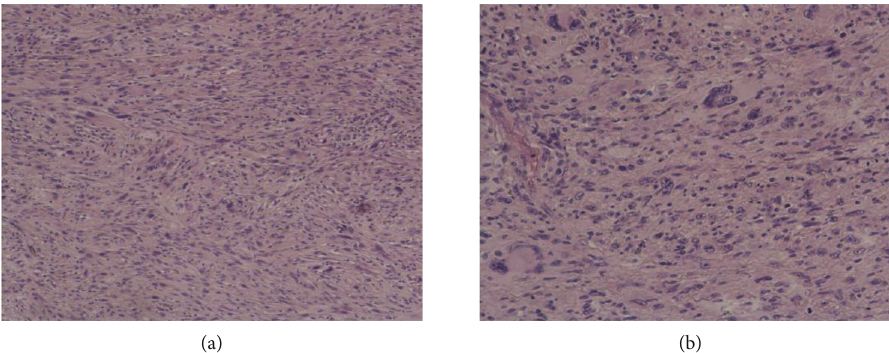
Figure 1: Spindle cell proliferation arranged in interlacing fascicles ( × 100) (a), with marked cytonuclear atypia at high magni fi cation ( × 200) (b).